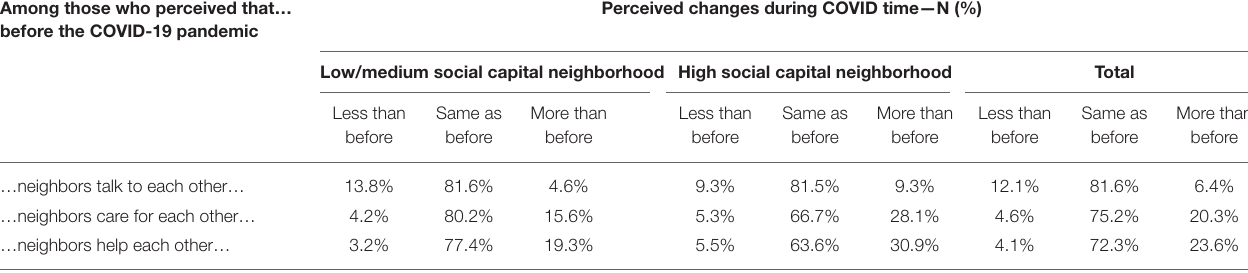
TABLE 2 | Changes in social interaction and support during COVID-19 across different neighborhoods. Among those who perceived that… before the COVID-19 pandemic